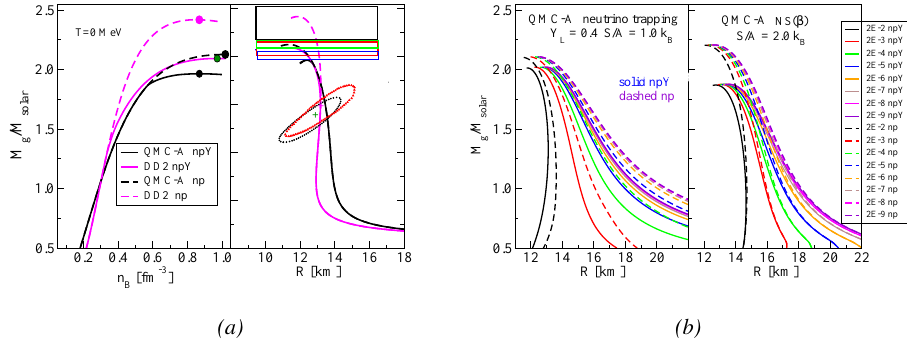
Figure 3: (a) NS masses vs the central baryon density (left) and radius (right) computed with the QMC- A and DD2 models for hyperonic (solid line) and nucleonic (dashed) matter. Observational limits on the maximum mass configuration are illustrated by black dashed [10], green dot-double dash [11], red dot-single dash [12] and solid blue [13] rectangles. The NICER limits on the radius of a ∼ 1.4 M (cid:12) PSR J0030-0451 [14] (magenta full triangles) and [15] (dark green full circles) are added for completeness. The coloured full circles in the left panel indicate the maximum mass. (b) Illustration of search for the surface of a hot star with fixed Y p and S / A = 1 k B (left) and the for NS in β (right). The figure is adapted from